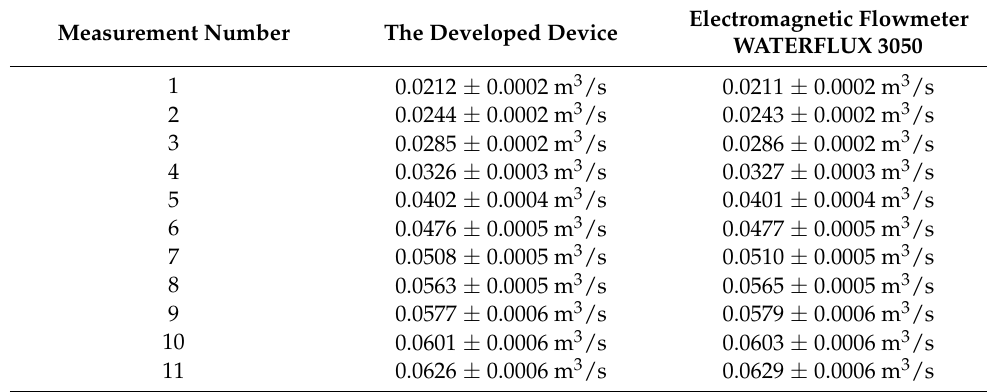
Table 2. Results of measuring the consumption q c of an aqueous solution (H 2 O + H 3 BO 3 ) with plutonium nitride filling at a temperature of T = 333.5 K in the pipeline of the experimental stand by various devices.